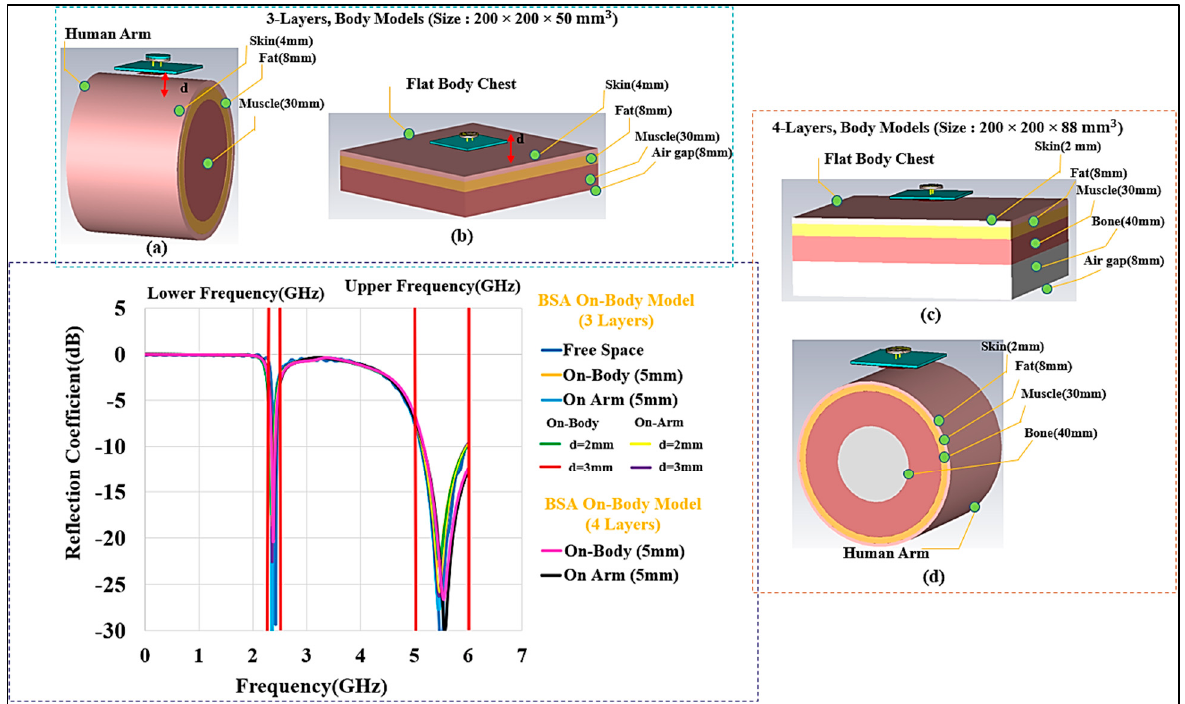
Figure 11. S 11 for BSA. ( b , c ) on the body chest (flat), with a thickness of 50 mm and 88 mm, respec- tively, and ( a , d ) arm cylindrical models, with a radius of 50 mm and 100 mm.